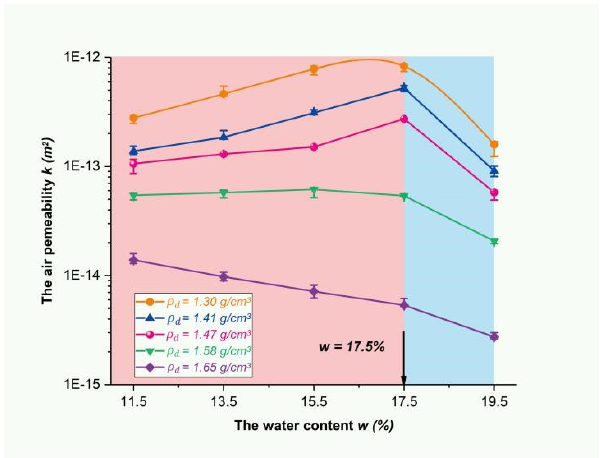
Figure 10. The air permeability of remolded loess samples.